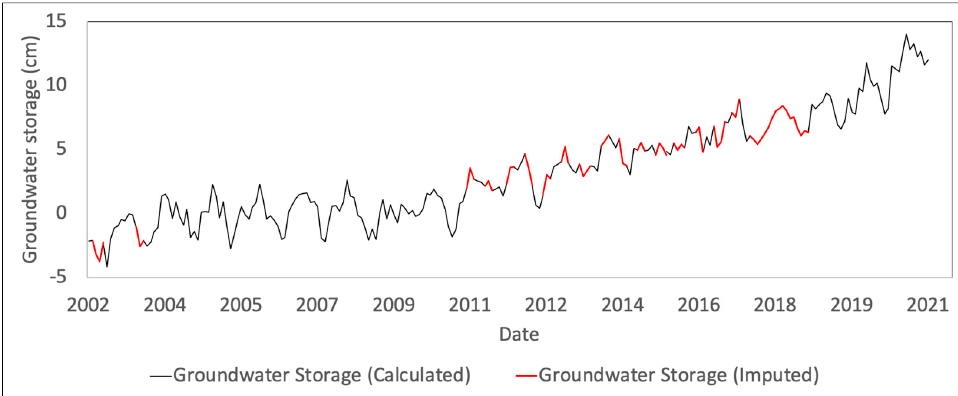
Figure 7. Measured (black) and imputed (red) GWSa data showing that visually, the imputed data honor the long-term trend and seasonal variation present in the data.